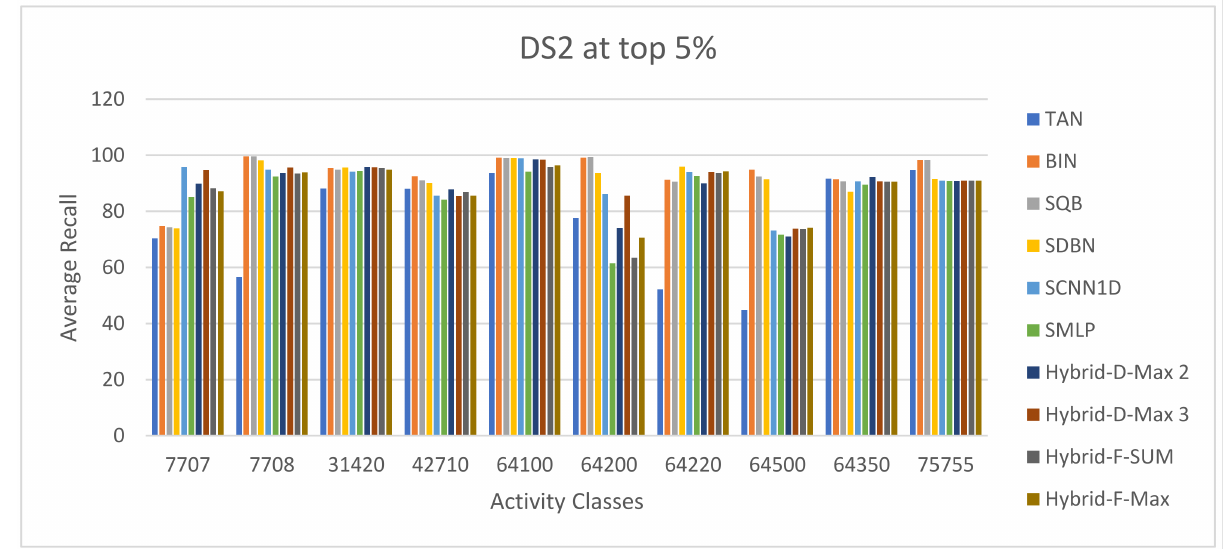
Figure 11. The comparison among methods for the average recall percentage at the top 5% in MDDR-DS2